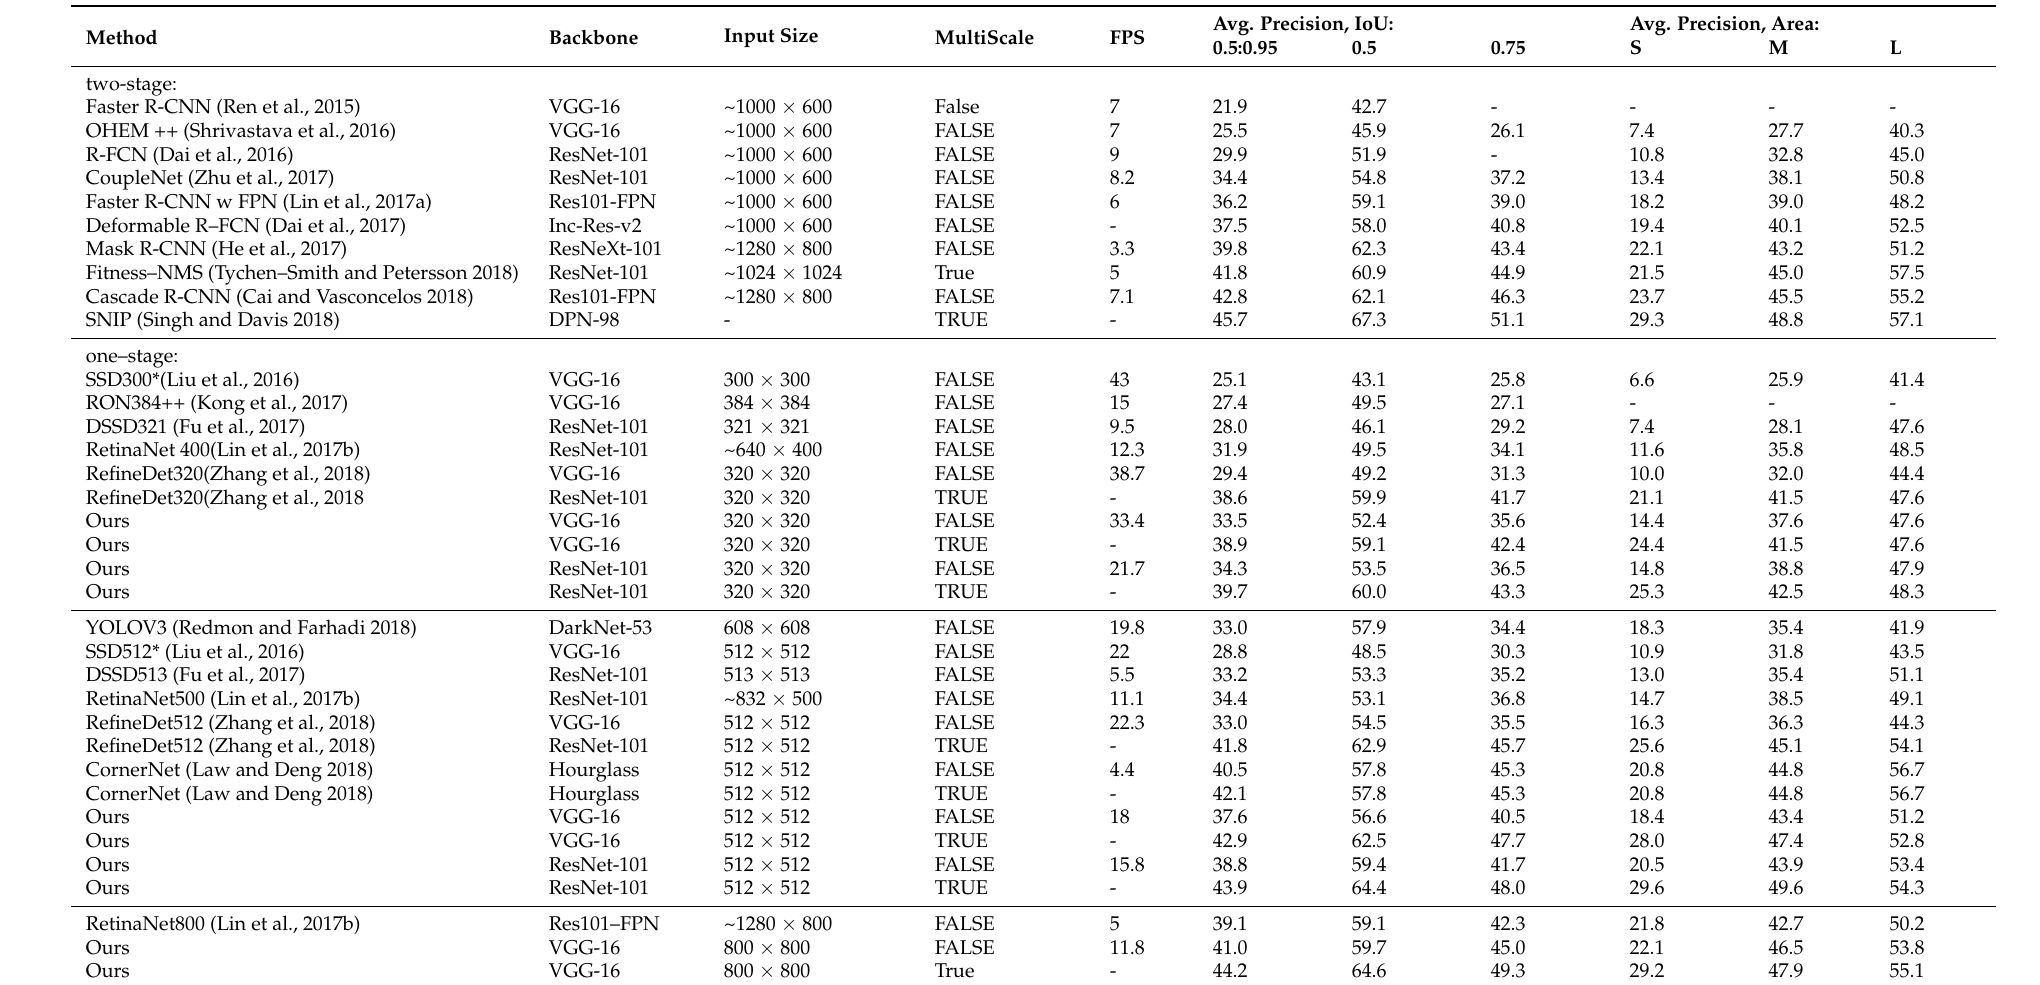
Table 3. State-of-the-art methods